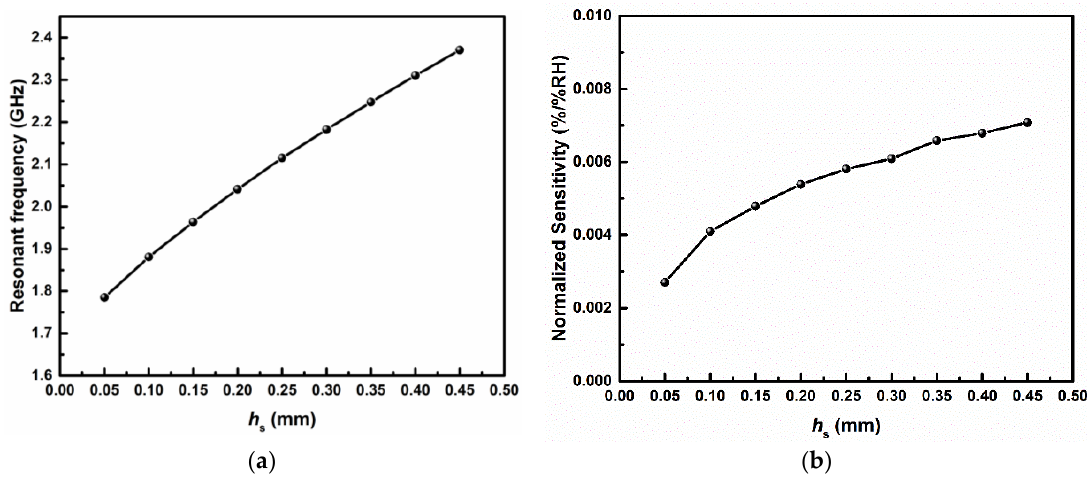
Figure 3. Simulated ( a ) resonant frequency and ( b ) normalized sensitivity of the sensor with varying heights of the sensitive region, h s .